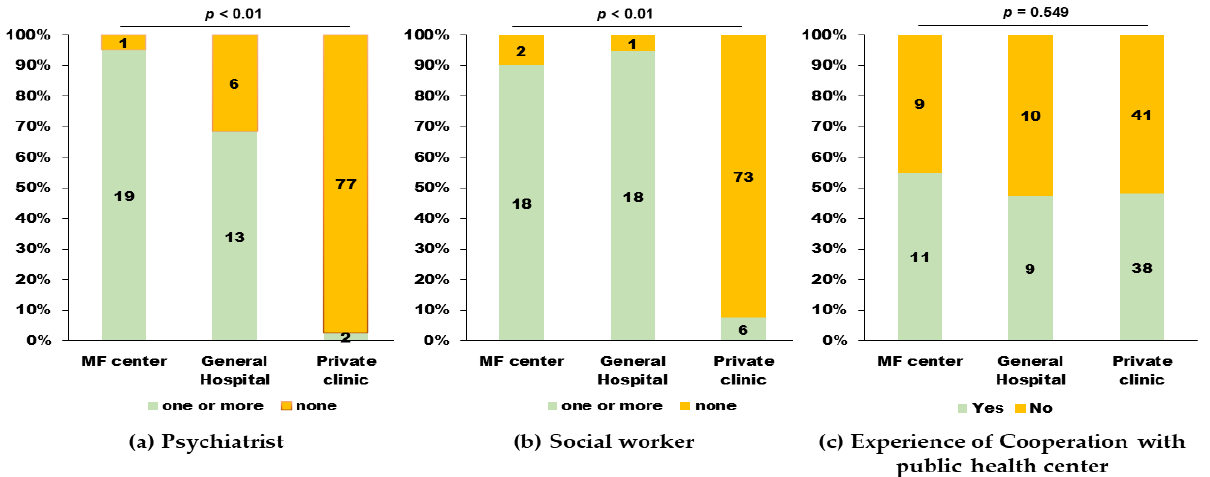
Figure 3. Multidisciplinary perinatal mental health care resources across different units: Maternal-fetal (MF) centers, gen- eral hospitals, and private clinics. ( a ) The distribution of psychiatrists. ( b ) The distribution of hospital social workers. ( c ) Experience of seamless multidisciplinary collaboration between medical units and community health